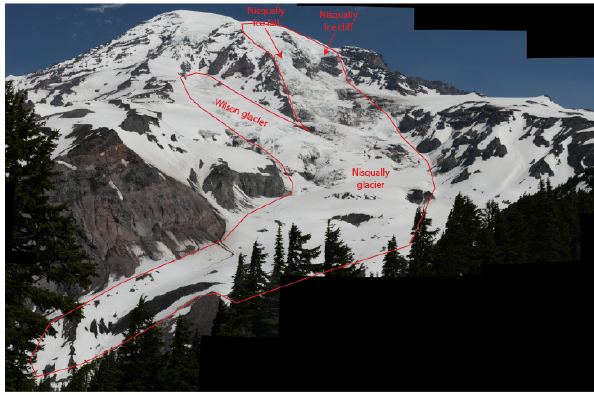
Figure A4. Pair of multi-look intensity radar images from ROI viewpoint (left and center) generated from original single-look complex (SLC) images multi-looked by 15 samples in range and multi-looked interferogram generated from the SLC images (right).